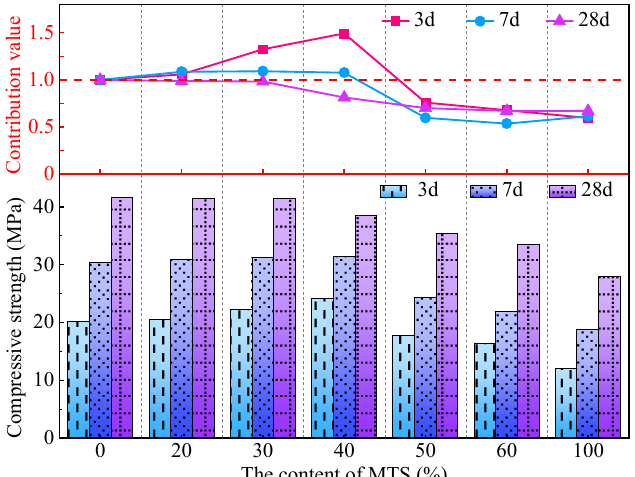
Figure 6. Effect of MTS content on compressive strength of MTSC and strength contribution value.